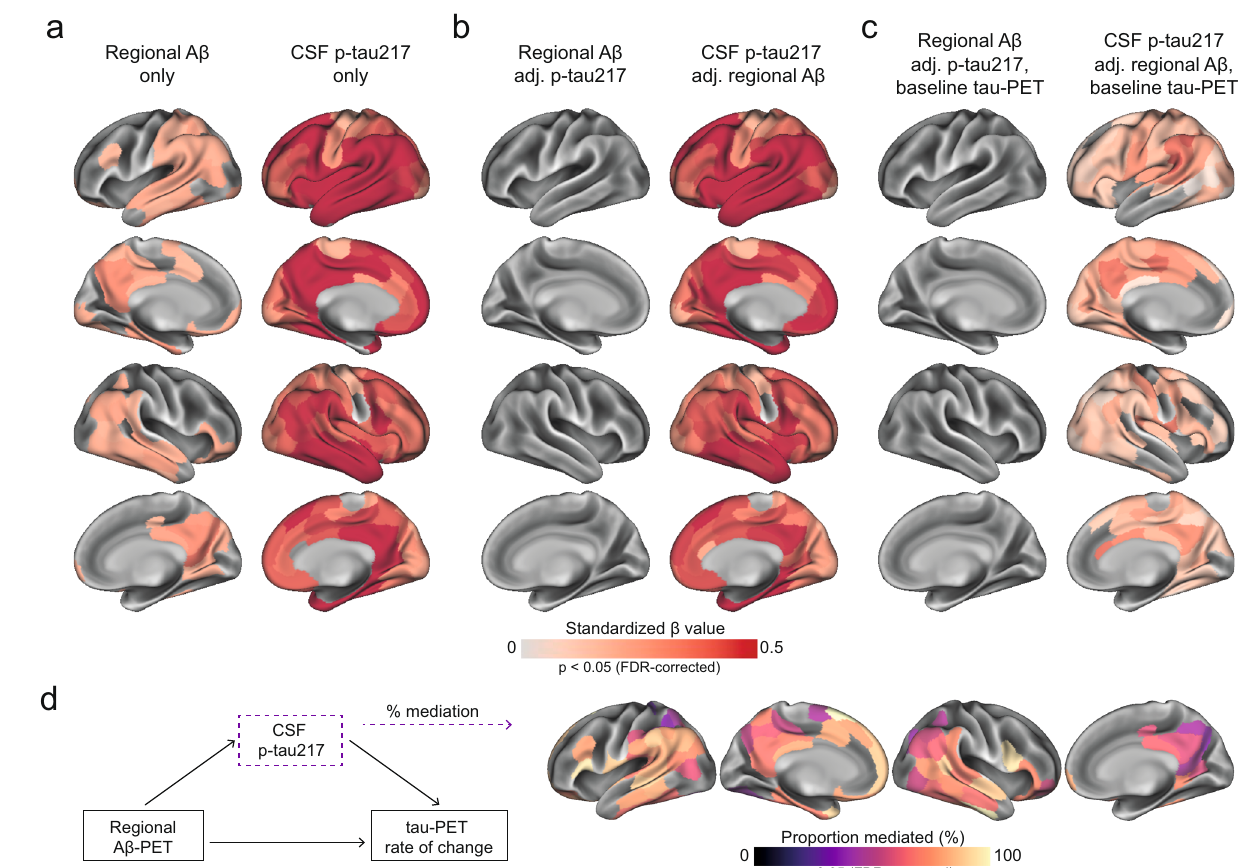
Fig. 2 | Regional A β -PET and CSF p-tau217 associations with regional tau-PET [ 18 F]RO948 rate of change in A β -positive non-demented participants. a Standardized beta coef fi cient of local A β -PET in regions where regional A β -PET fl utemetamol SUVR (left column) relates to regional tau-PET rate of change, adjusting for age and sex. Right columns were derived from a similar model, but using CSF p-tau217 as predictor instead of A β -PET. b Standardized beta coef fi cient where local A β -PET (left column) and CSF p-tau217 (right column) is associated to regional tau-PET rate of change when including both biomarkers in the same model,adjustingforageandsex(tauPETrateofchange ∼ regionalA β -PET+CSFp- tau217+age+sex). c Same depiction as in b , when additionally controlling for